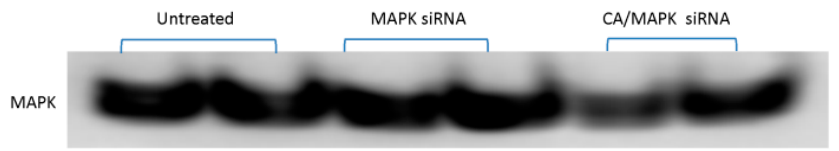
Figure 2. MAPK protein expression in MCF-7 cells. Cells were treated with media (untreated), free MAPK siRNA, and CA / MAPK siRNA formed with 3 mM of CaCl 2 and 1 nM siRNA for 44 h. Cellular lysates were resolved by SDS-PAGE and transferred into PVDF membrane followed by incubation with primary antibodies raised in rabbit against AKT. HRP-conjugated goat anti-rabbit secondary antibody was used to detect the chemiluminescent signals.